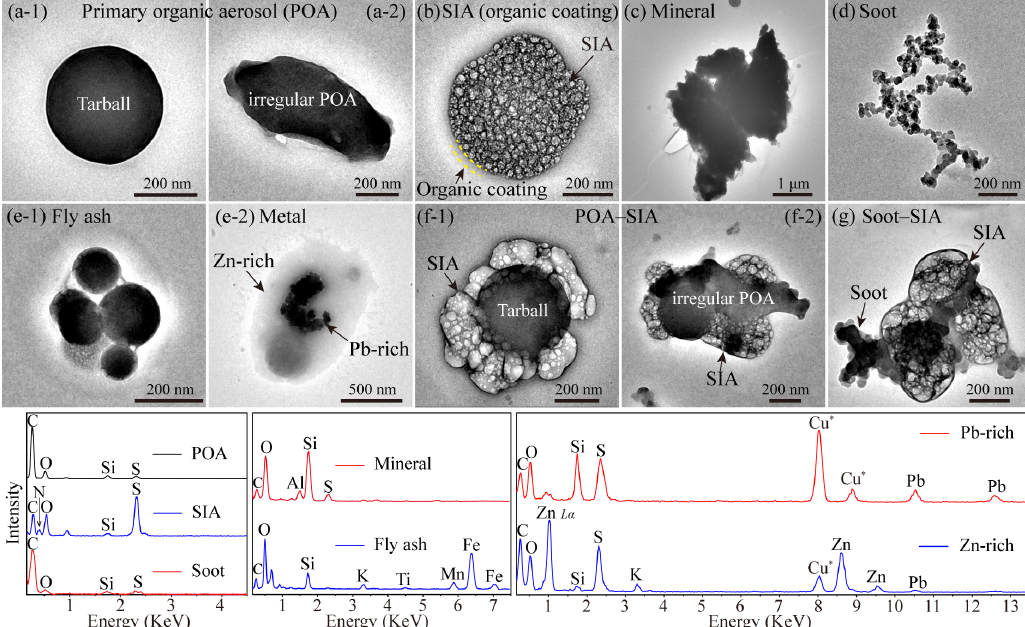
Figure 3. Typical transmission electron microscopy (TEM) images and energy-dispersive X-ray spectrometer (EDS) spectra showing the morphology, composition, and mixing structures of different individual particle types. (a) Primary organic aerosol (POA) particles with (a- 1) spherical (i.e., tarball) or (a-2) irregular shapes; (b) secondary inorganic aerosol (SIA) particle with secondary organic coating; (c) mineral;